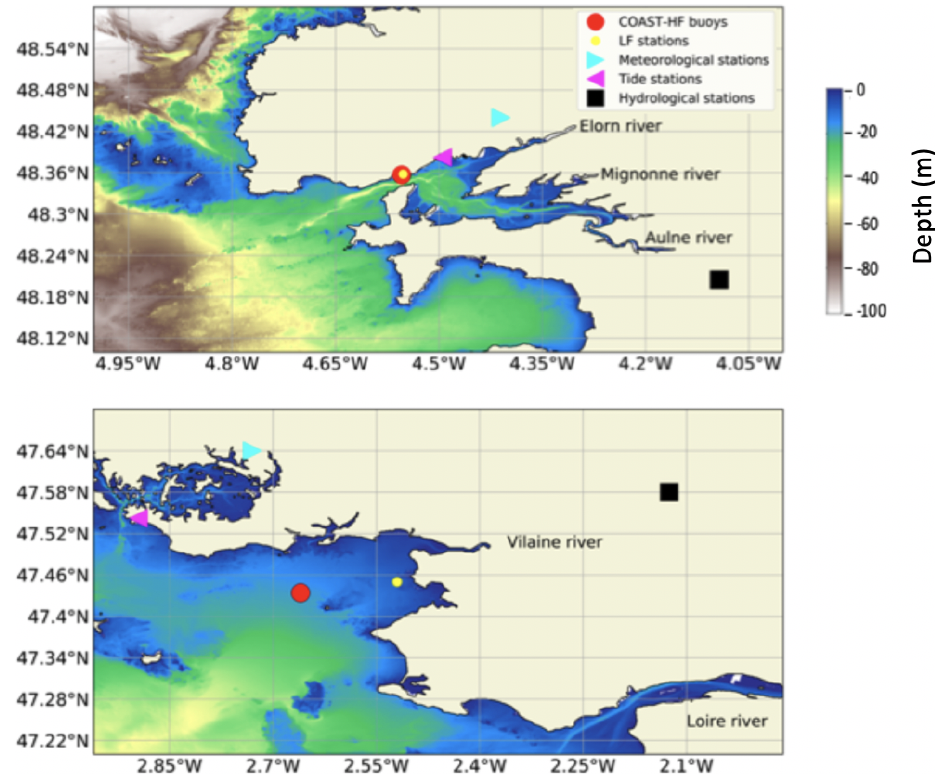
Figure 1. Location of the sampling sites: COAST-HF-Iroise and COAST-HF-Molit buoys (red circles); SOMLIT-Brest and REPHY-Loscolo sampling stations (yellow circles); Brest and Crouesty tide gauge stations (blue triangles); Guipavas and Vannes-Séné meteorological stations (purple triangles); hydrological stations of the Aulne and Vilaine rivers (black squares), with the Loire station off the